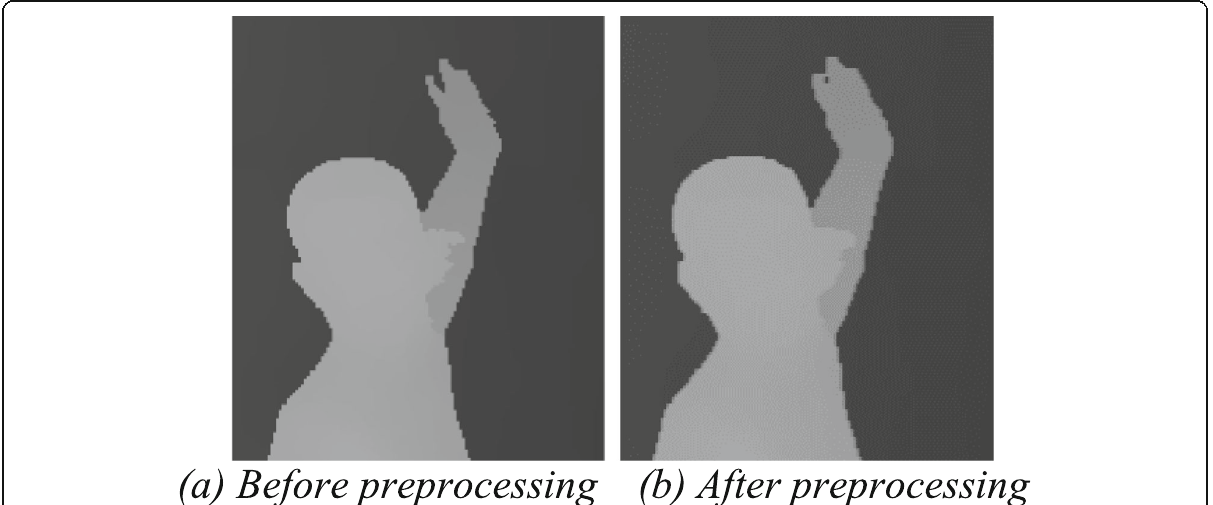
Fig. 3 Contrast before and after preprocessing in depth map. a Before preprocessing. b After